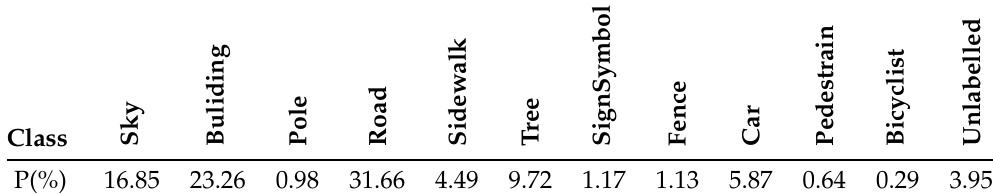
Table 7. The category proportion of the CamVid training